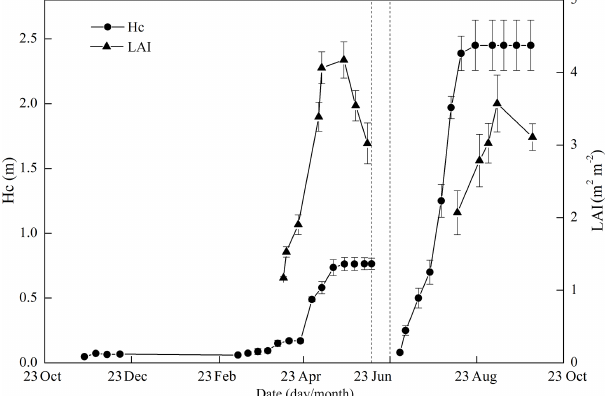
Figure 6. Seasonal variations in the total dry biomass (DM) and its major components of root, stem, green leaf and grain. The error bars of total biomass denote 1 standard deviation of the four sample